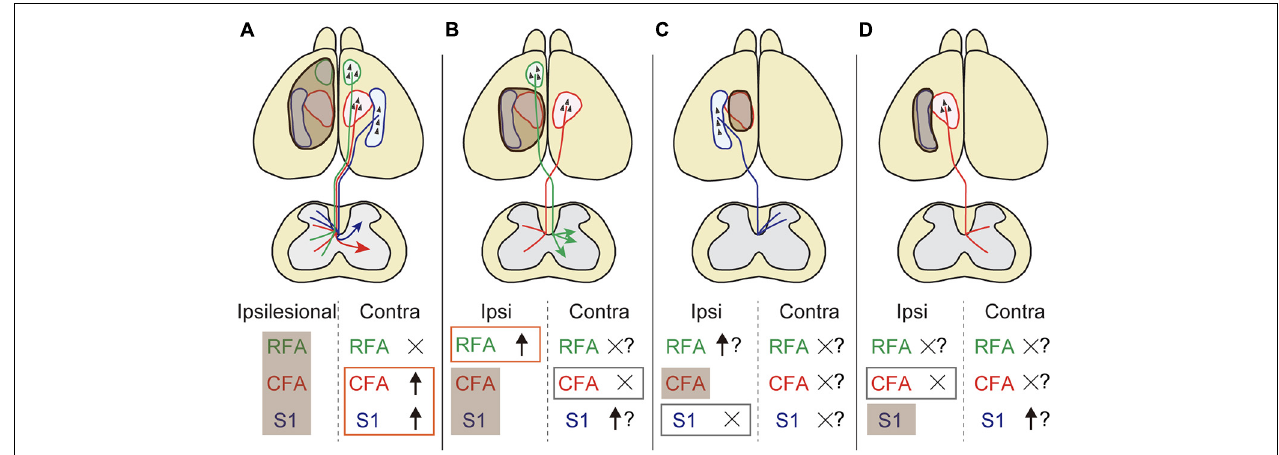
FIGURE 6 | The rewiring patterns of multiple CSTs in different stroke sizes and locations. (A) A large stroke that damages the sensorimotor area induces axon rewiring of the contralesional motor and sensory cortex on the denervated side of the cervical spinal cord. (B) The remnant ipsilesional CST axons that are functionally homologous are preferentially sprouted rather than contralesional ones in a small stroke. (C,D) Functionally non-homologous CST pathways cannot compensate mutually. Shaded brown boxes indicate the lesion area. Orange and gray boxes are the stroke-induced sprouting and non-sprouting CST pathways that are investigated in this study, respectively. Question marks mean putative involvement in rewiring based on the presumptive rules presented in this